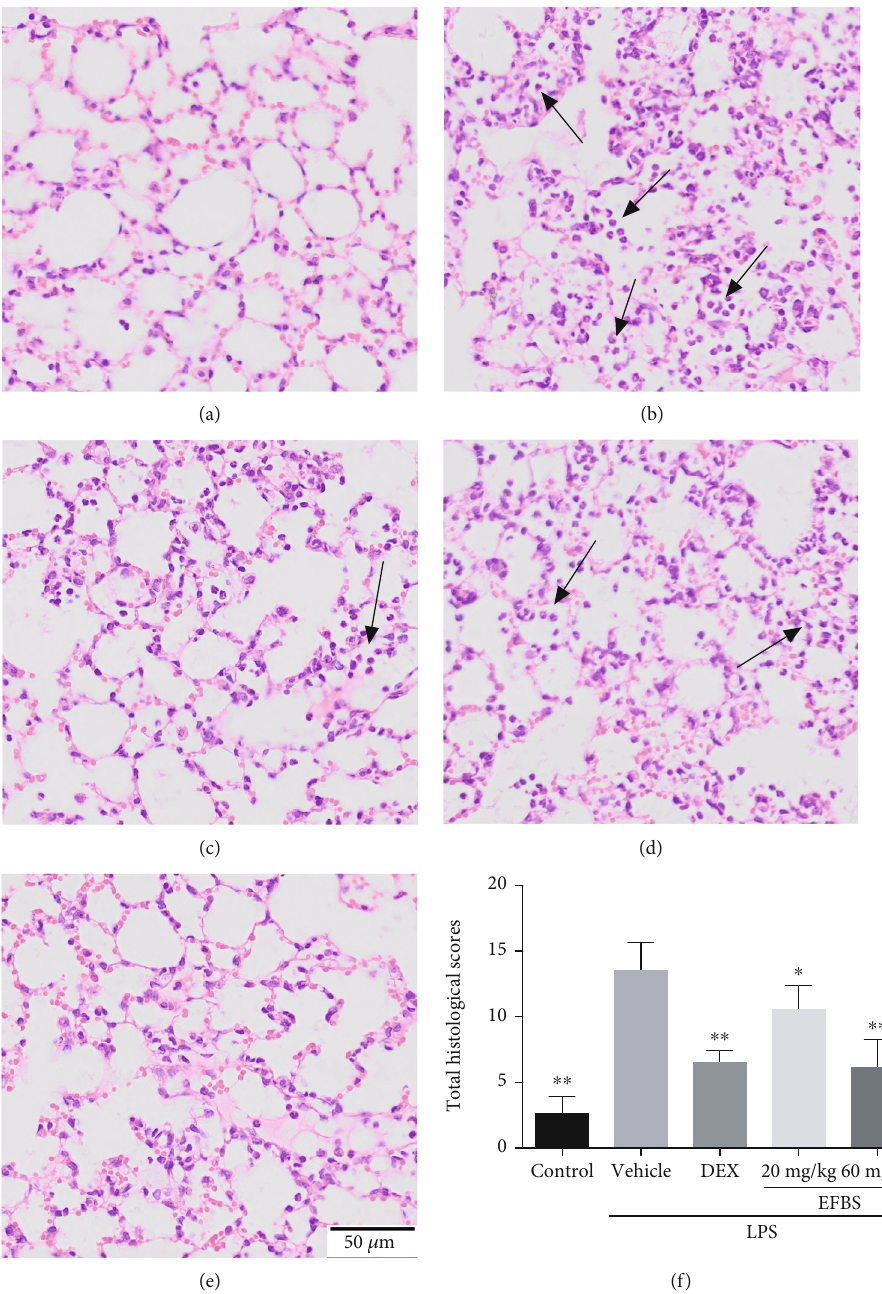
Figure 4: The e ff ects of EFBS on changes to lung histopathology (a – e) and total histopathological scores (f) induced by LPS. The ICR mice were (a) left untreated or challenged with LPS (5 mg/kg) for 6h following (b) no pretreatment or pretreatment with (c) 5mg/kg DEX, (d) 20mg/kg EFBS, or (e) 60mg/kg EFBS. Black arrow indicates neutrophils in fi